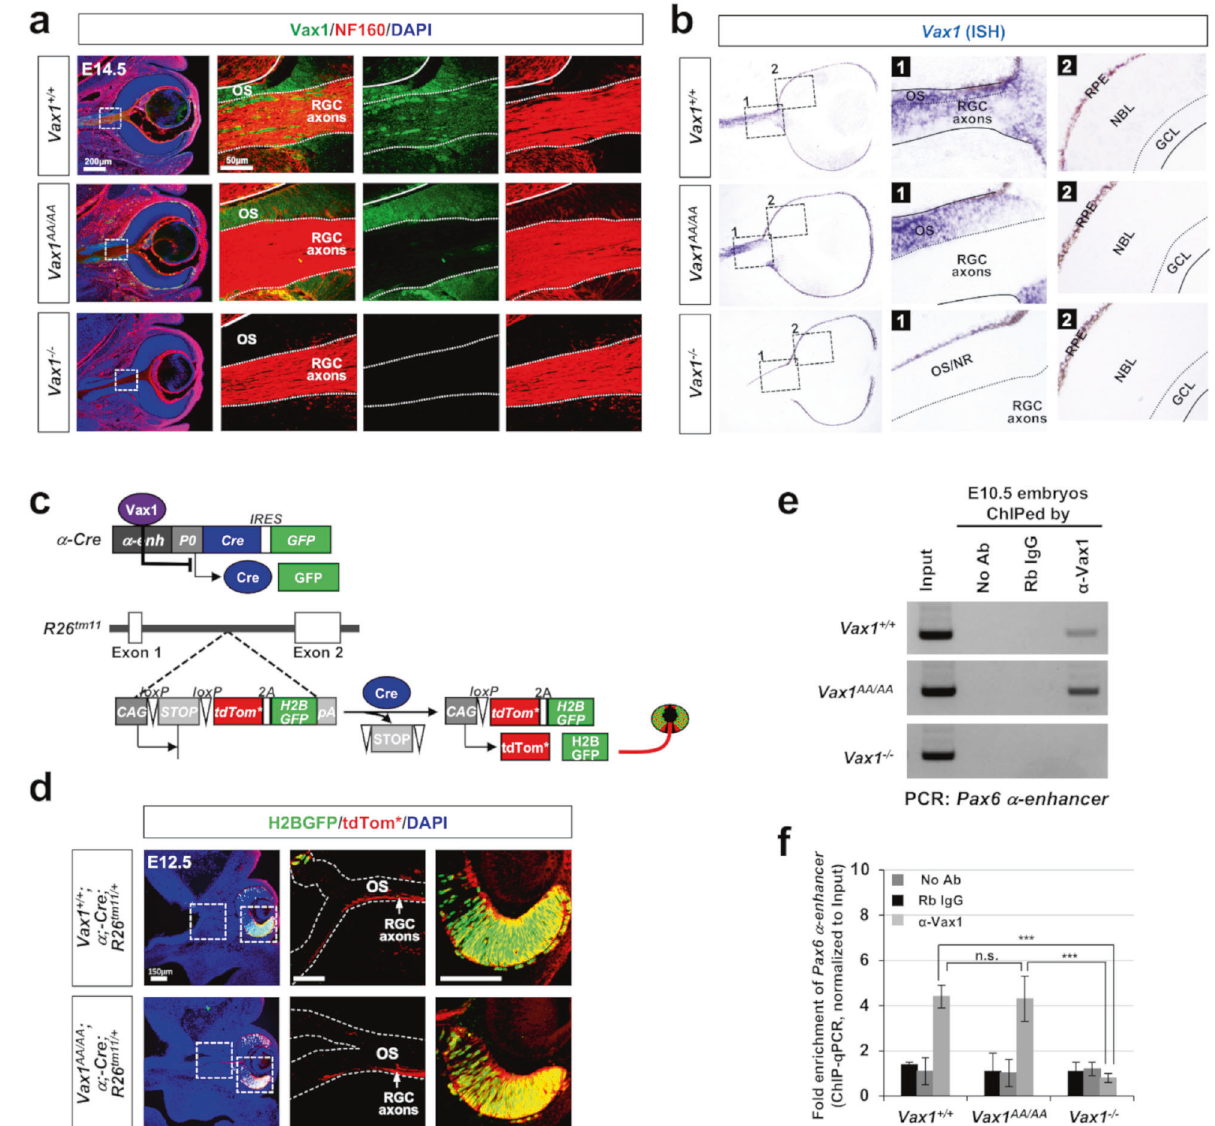
Fig. 2 Vax1 AA exhibits defective intercellular transfer but intact transcription factor activity in vivo. a Intercellular transfer of Vax1 from E14.5 Vax1 + / + and Vax1 AA/AA littermate mouse OS cells to RGC axons was determined by immunostaining of the embryonic sections with α - Vax1 (green) and α -NF160 (red). b Expression of Vax1 and Vax1 AA mRNA in E14.5 Vax1 + / + and Vax1 AA/AA littermate mouse eyes and OS was examined by ISH. Boxed areas in the leftmost column are magni fi ed in two right columns. The speci fi cities of the anti-Vax1 antibody (a) and Vax1 ISH probe (b) were determined by the absence of signals in E14.5 Vax1 − / − mice. The ISH signals of the sense probes for Vax1 did not exhibit speci fi c signals (data not shown). The solid lines in the images indicate the boundary of OS, and the dotted lines mark the border between the OS and RGC axon bundles. NR, neural retina; RPE, retinal pigment epithelium; NBL, neuroblast layer; GCL, ganglion cell layer. c The activities of a Vax1 target Pax6 α -enhancer in mouse embryos were measured by detecting H2B-EGFP, the expression of which is induced together with membrane-bound tdTomato (tdTom*) at the R26 tm11 gene locus after α -Cre-dependent excision of the loxP-STOP-loxP cassette. Arrowheads point to the frontlines of the RGC axons. d Binding of Vax1 and Vax1 AA proteins to the Pax6 α -enhancer was determined by PCR detection of Pax6 α -enhancer sequences in DNA fragments isolated from E10.5 mouse embryonic cells by ChIP with the indicated antibodies (see details in Methods). Input, mouse chromosomal DNA; No Ab, no antibody; Rb IgG, preimmune rabbit IgG; α -Vax1, rabbit anti-Vax1 polyclonal antibody. e Relative levels of Pax6 α -enhancer sequences in the ChIPed samples were compared by qPCR. f The numbers on the y-axis are the average 2 - Δ Ct values of the samples against the critical threshold (Ct) values of the input. Error bars denote SD ( n = E16.5 Vax1 AA/AA mice, similar to the distribution observed in Vax1 + / + littermates, S100ß-positive OS cells entirely lost E-cad expression (Fig. 3d, left column of the E14.5 panel). The cells in the ventral OS and started to disperse between RGC axons, whereas S100ß- (vOS) of E14.5 Vax1 AA/AA mice also expressed S100 without E-cad, negative OS cells still formed Ecad-positive neuroepithelial clusters in E16.5 Vax1 − / − mice (Fig. 3d, E16.5 panel). These results while those in the dOS coexpressed S100ß and E-cad (Fig. 3d, center column of the E14.5 panel). The vOS cells in E14.5 Vax1 − / − suggest that the differentiation of S100ß-positive APCs from the OS neuroepithelium is impaired in Vax1 − / − mice but merely mice, however, did not express S100ß; instead, they expressed the retinal marker Vsx2 (Fig. 3d, right column of the E14.5 panel). In delayed in Vax1 AA/AA mice.